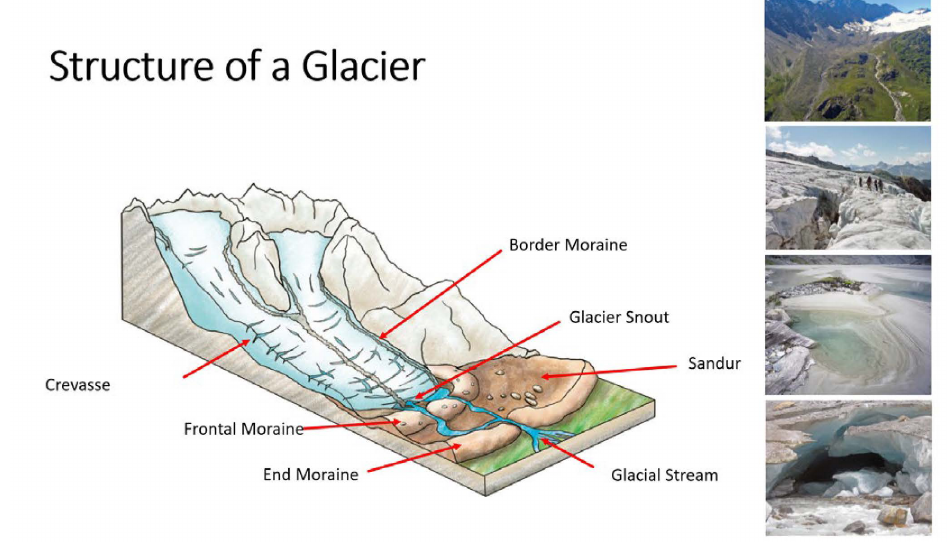
Figure 2. Sample Screen from the learning